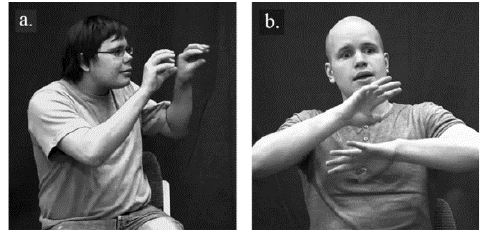
Figure 1. Two examples of how CA is used in FinSL. In (a), CA co-occurs with a depictive Type 3 verbal including handling clas- sifier handshapes, the whole expression representing a boy putting coals as eyes on a snowman. In (b), CA is manifested as a whole-body gesture showing a snowman pulling back from a hot